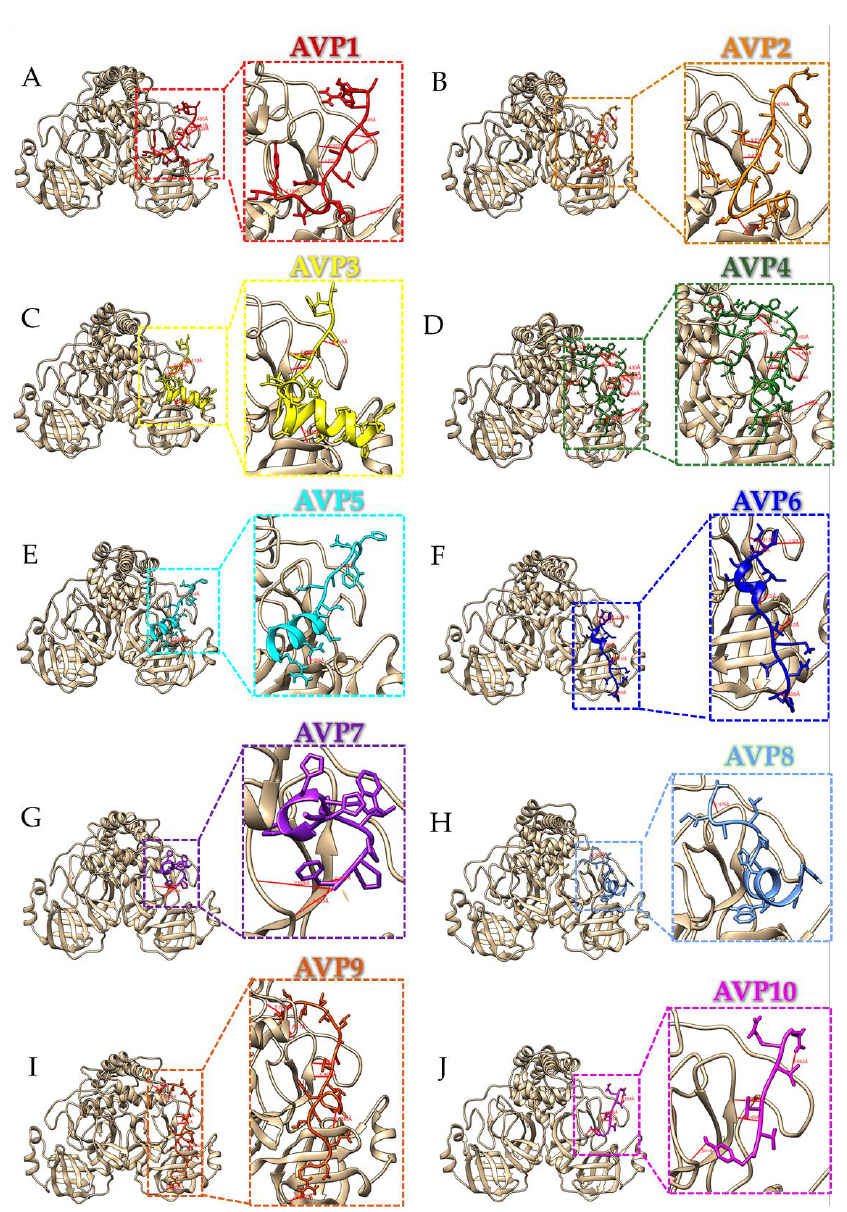
Figure 5. Molecular docking of the ten top-ranked AVPs (AVP1 ( A ), AVP2 ( B ), AVP3 ( C ), AVP4 ( D ), AVP5 ( E ), AVP6 ( F ), AVP7 ( G ), AVP8 ( H ), AVP9 ( I ), and AVP10 ( J )) to the crystal structure of the SARS-CoV-2 main protease in the apo state (PDB ID: 7C2Q). The structure of the SARS-CoV-2 main protease is shaded in gold, and the peptide sequences are colored as labeled above. The hydrogen bonds are shown as red lines.